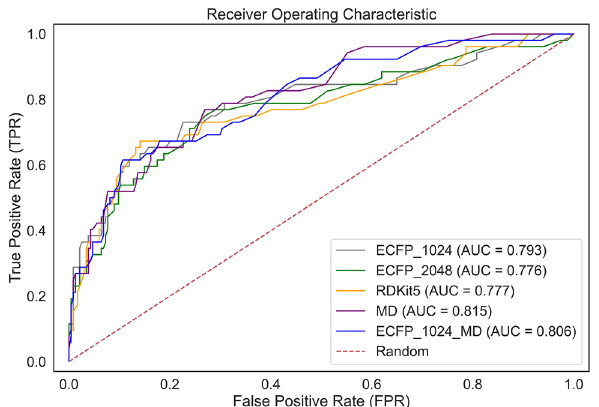
Figure 2. The ROC curves comparing the performances of the ECFP_1024 (in grey), ECFP_2048 (in green), RDKit5 (in orange), MD (in purple) and ECFP_1024_MD (in blue) for classifying the compounds in the test set. The AUC scores are reported for each descriptor type. The red dashed line corresponds to a random classifier, that gives random answers, with an AUC value of 0.5 20